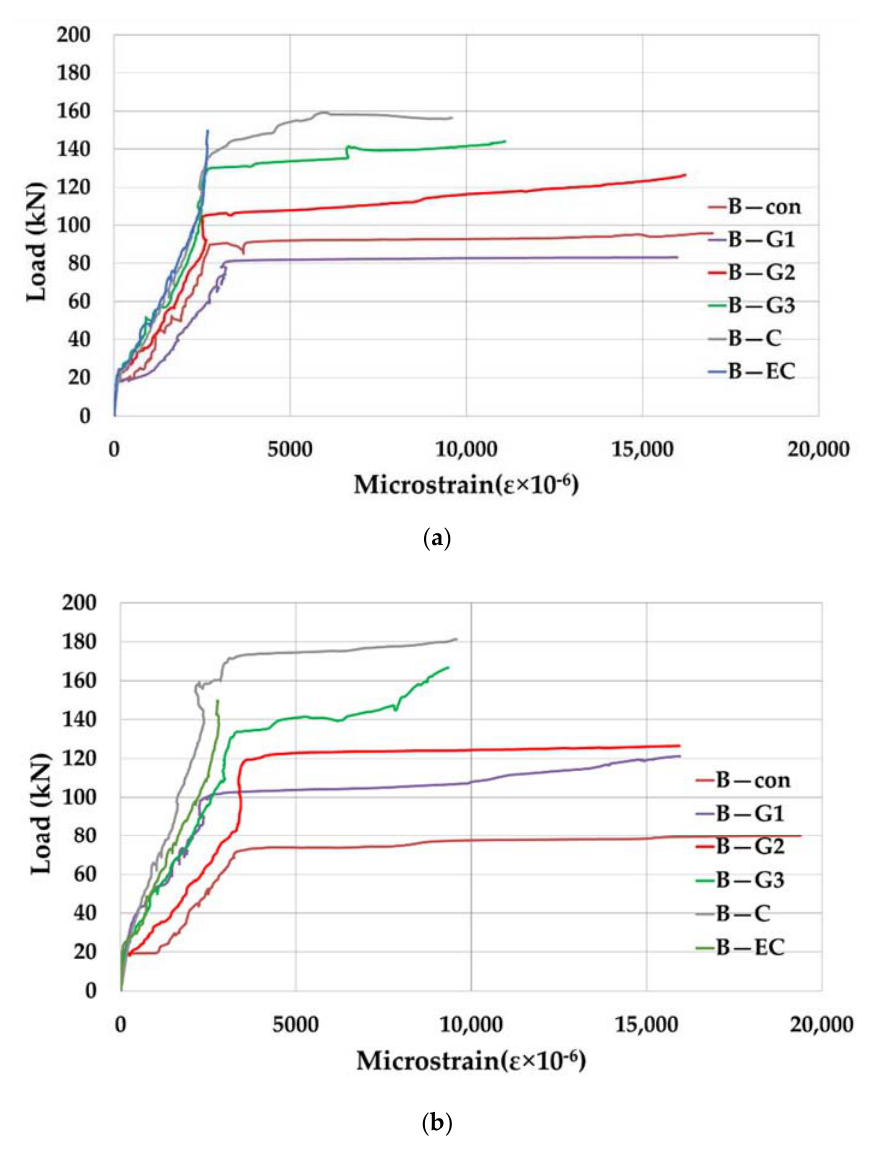
Figure 12. Load vs. microstrain curves in steel reinforcement for the section: ( a ) At the middle of span—Section I; ( b ) Above the middle support—Section III.